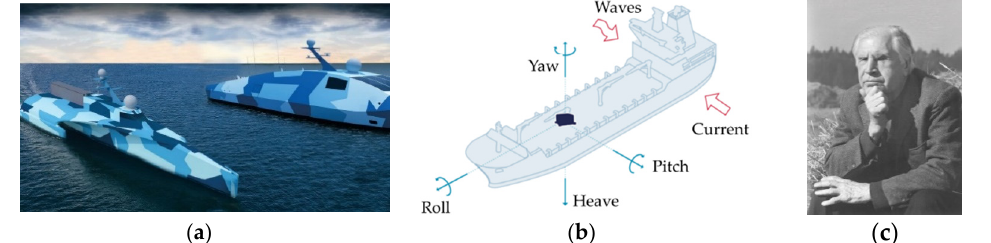
Figure 1. Representative motion measurement units for future ships depicted in ( a ) with measurement bases depicted in ( b ) are proposed to be augmented by virtual sensoring by minimization of Hamiltonian systems by the principles of Pontryagin depicted in ( c ). Future unmanned U.S. Navy vessels [3] Medium Unmanned Surface Vessel (MUSV) concept renderings in ( a ) from shipbuilder Austal USA. Photo Credit: Austal USA. Boat motion monitoring [4] uses measurement bases depicted in ( b ) whose graphic is from cited reference modified by author. Photo ( c ) of Lev Pontryagin from the archive of the Steklov Mathematical Institute [2] used with permission (30 June 2021)